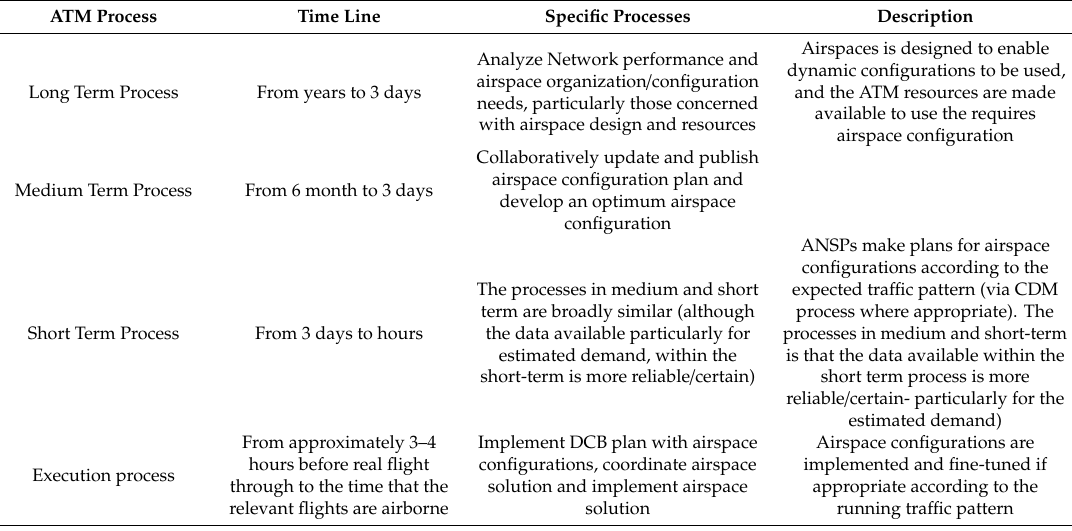
Table 2. Dynamic airspace configuration description in ATM processes.